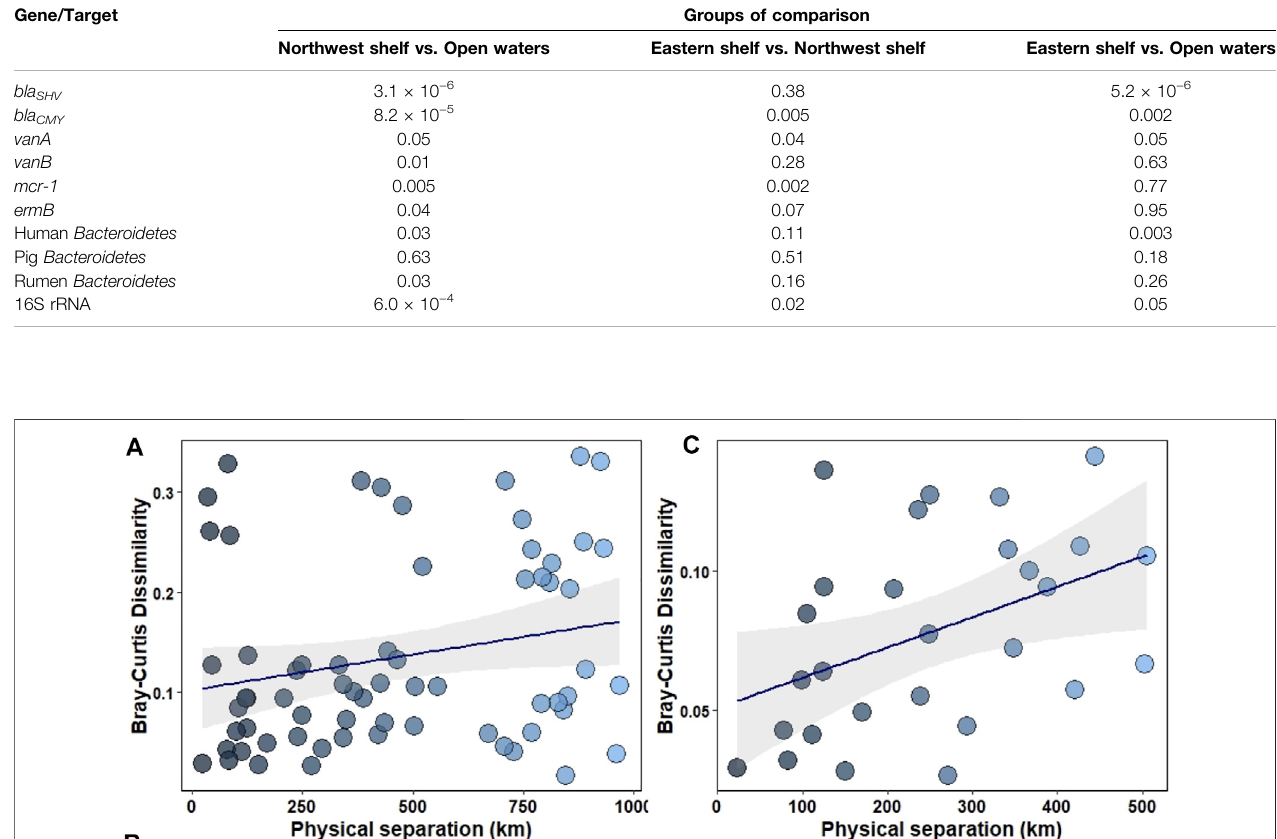
Frontiers in Environmental Science |